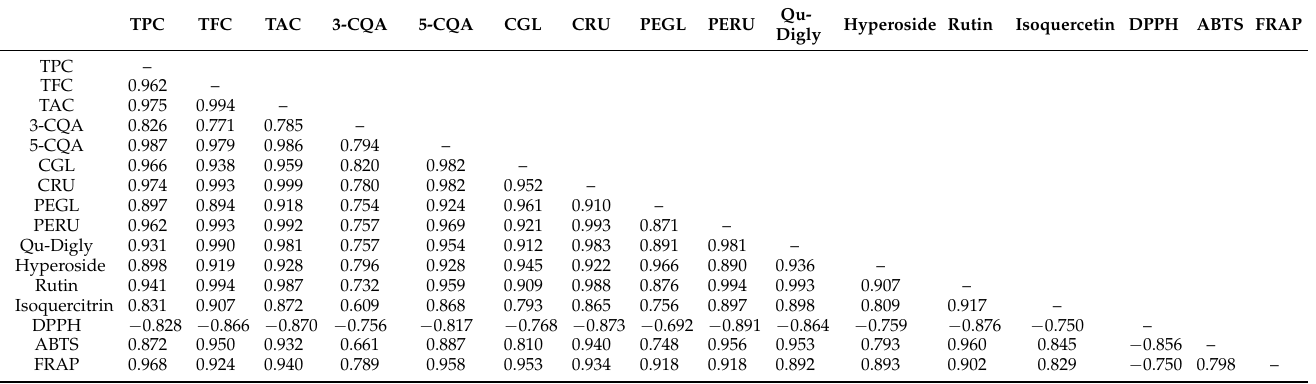
Table 6. Pearson’s correlation coefficients (r) between phenolic content (TPC, TFC, TAC, and individ- ual compounds) and antioxidant activities (DPPH, ABTS, and